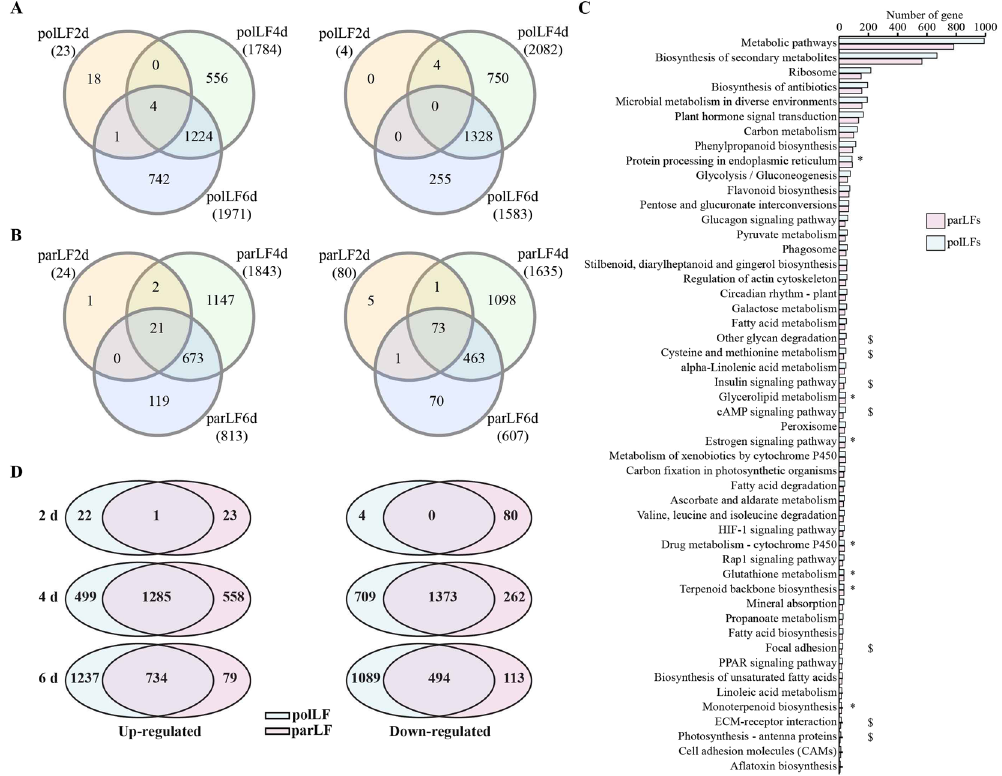
Figure 2. DEGs identified in polLFs and parLFs. edgeR was used to identify the DEGs with strict criterial (log2FC > 1 or log2FC <− 1, FDR < 0.05) in polLFs ( A ) and parLFs ( B ). KEGG pathway analysis ( C ) revealed most of the pathways were shared by DEGs in polLFs and parLFs. * and $ represent the pathways identified with significant enrichment by the DEGs only in polLFs and parLFs, respectively ( D ) Venn diragrams of DEGs identified in polLFs and parLFs at different developmental stages. Left panel: up-regulated genes; right panel: down-regulated